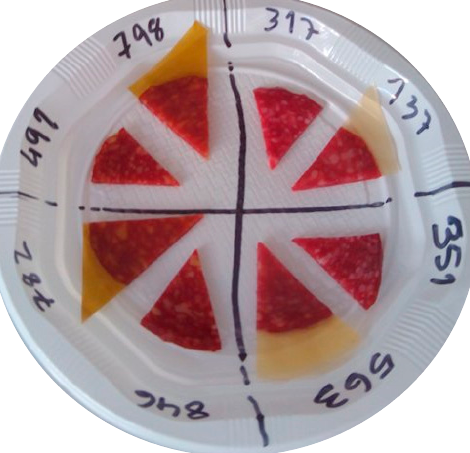
Figure 2. Presentation of the samples to the sensory panel. The code is decrypted in Table 2. Table 2. Decoding of the samples in study presented in Figure 2.